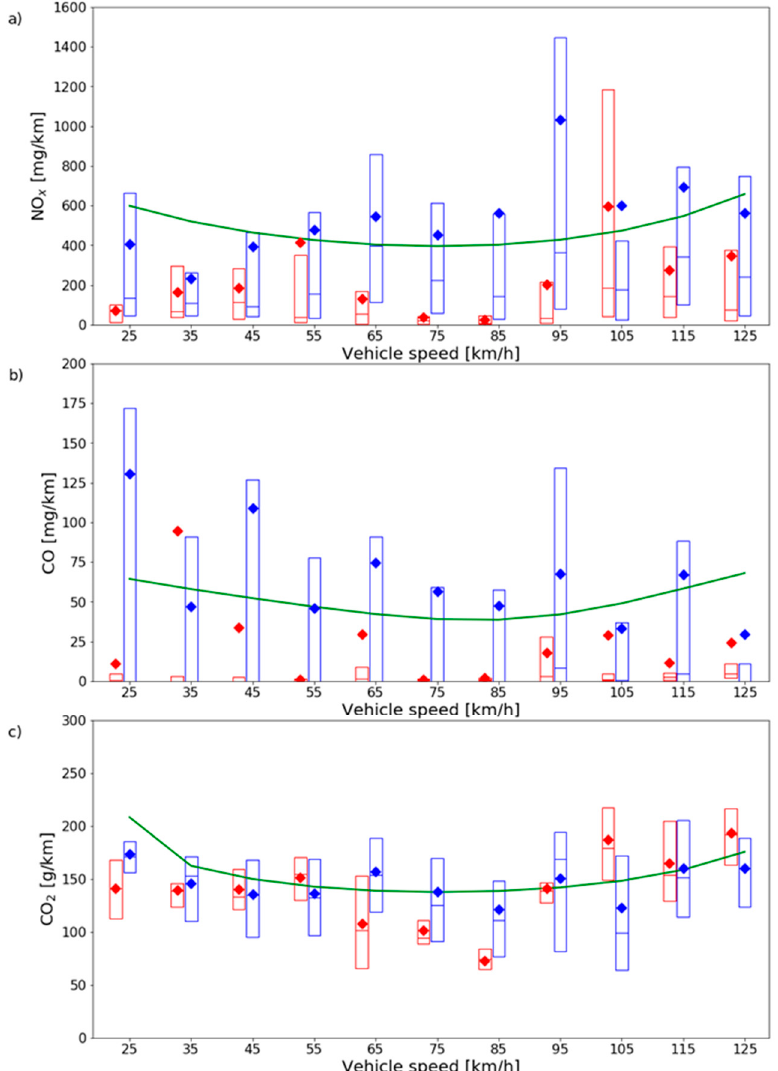
Figure 5. Distribution of diesel sample emissions as a function of speed over WLTC Hot (red boxes), RDE without first five minutes (blue boxes), and EFs retrieved from EMEP / EEA inventory guidebook (green line) for ( a ) NO X ( b ) CO, and ( c ) CO 2 . The box represents the 1st and 3rd quartile, the line inside the box is the median, and the diamond is the mean.